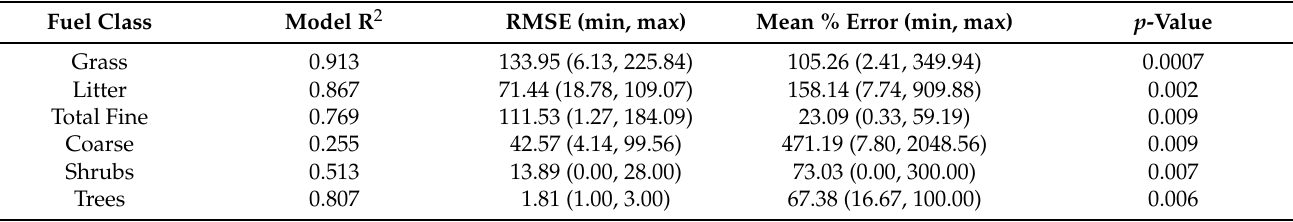
Table 3. Model prediction Root Mean Squared Error (RMSE), mean percentage error and the p -value for different fuel classes, with corresponding error ranges where relevant. Percentage error was calculated as a percentage of the measured value; in the instances where the measured value was zero, it was set to one to avoid zero